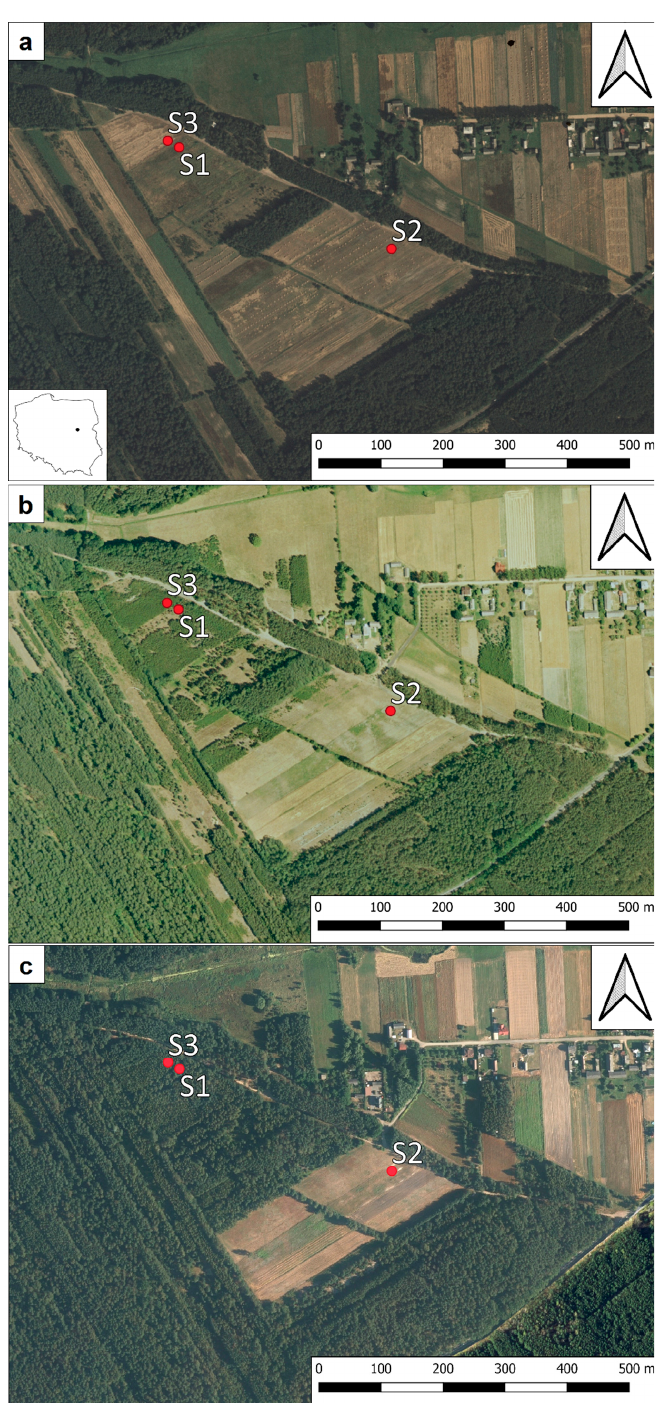
Figure 1. Location of the study sites: Dicrano-Pinion S1, Scleranthion annui S2, and Molinio-Frangulion S3, with the historical land uses, ( a )—1997, ( b )—2006, and ( c )—2018. Source of orthophotomaps: Geoportal [38].